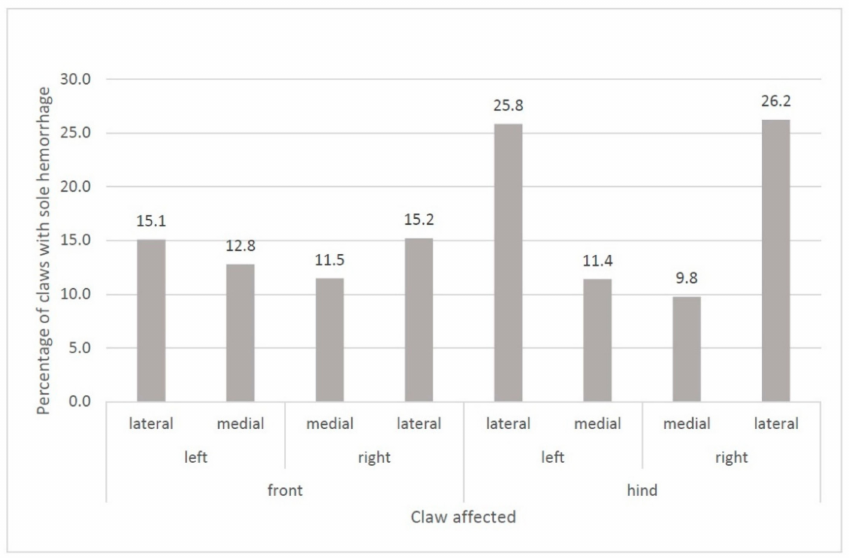
Figure 6. Localization of sole